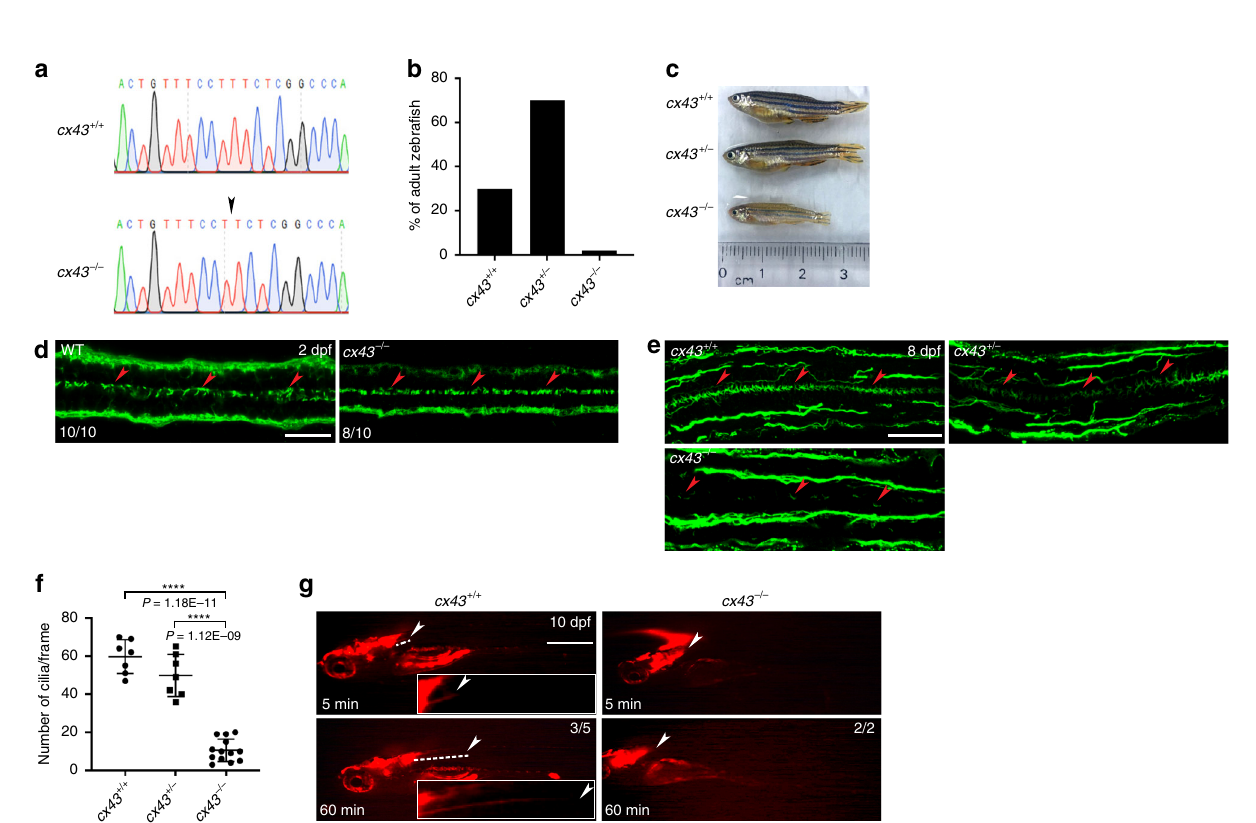
Fig. 4 The electrochemical coupling function of Cx43 plays an important role in the maintenance of ependymal motile cilia. a Domain structure of Cx43. TM, transmembrane. b , d Embryos at one-cell stage were microinjected with control MO, cx43 MO or cx43 MO + mRNA encoding mouse Cx43 lacking the C-terminal domain ( b ) or cx43 MO + mRNA that encodes mouse mutant Cx43 lacking the channel function ( d ), and IF stained with anti-acetylated α - tubulin antibody at 2 dpf. Arrowheads represent motile cilia. Dorsal view anterior to the left. Scale bar = 20 μ m. c , e Quanti fi cation of the number of ependymal motile cilia in b , d , respectively. Mean ± SD. ** P < 0.01 and **** P < 0.0001 by one-way ANOVA with Tukey ’ s HSD post hoc test: c n = 20 embryos per each group; e n = 10 embryos per each group except cx43 MO + cx43 T154A mRNA ( n = 7 embryos). ns, not signi fi cant. f Embryos were treated with carbenoxolone (1 μ M) at 18 – 48 hpf and immunostained with anti-acetylated α -tubulin antibody at 2 dpf. Arrowheads point to motile cilia. Dorsal view anterior to the left. Scale bar = 20 μ m. g Embryos at one-cell stage were microinjected with cx43 MO, treated with either DMSO (vehicle control) or BIO (5 μ M) at 12 – 48 hpf, and IF stained with anti-acetylated α -tubulin antibody at 2 dpf. Arrowheads represent motile cilia. Dorsal view anterior to the left. Scale bar = 20 μ m. h Quanti fi cation of the number of ependymal motile cilia per frame in embryos in g . Mean ± SD. **** P < 0.0001 by two-tailed unpaired Student ’ s t test ( cx43 MO + DMSO: n = 18 embryos; cx43 MO + BIO: n = 20 embryos; one frame per embryo). i Tg(foxj1a:GCaMP6s ) embryos expressing a calcium indicator (GCaMP6s) in ECs were microinjected at one-cell stage with control MO or cx43 MO, and cx43 morphants were treated with BIO (5 μ M) at 12 – 48 hpf. Subsequently, they were subjected to time-lapse imaging for 3 min (20 frames/min) with a confocal microscope. Dorsal view anterior to the left. Scale bar = 20 μ m. j The GFP fl uorescence intensity in ten cells (1 – 10) in each embryo in i was individually assessed at 0 (F 0 ), 60 (F 60 ), 120 (F 120 ) and 180 s (F 180 ), and presented as F 60 /F 0 , F 120 /F 0 and F 180 /F 0 .